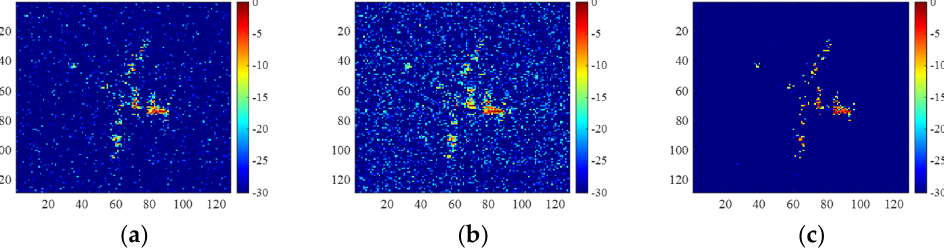
Figure 14. Yak-42 images of the incomplete azimuth data obtained by ( a ) 2D-FISTA, ( b ) untrained Figure 14. Yak ‐ 42 images of the incomplete azimuth data obtained by ( a ) 2D ‐ FISTA, ( b ) untrained